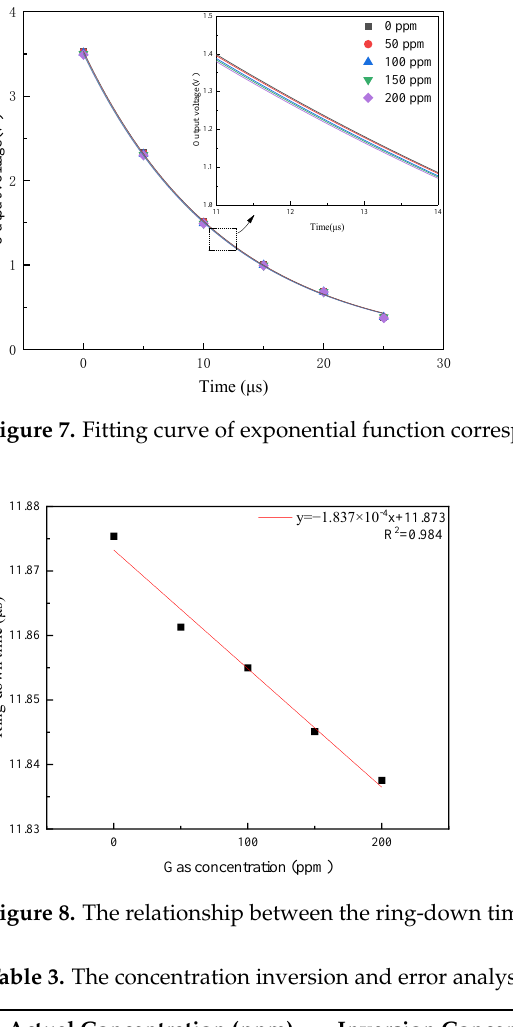
Figure 6. Original waveform under N 2 background gas.